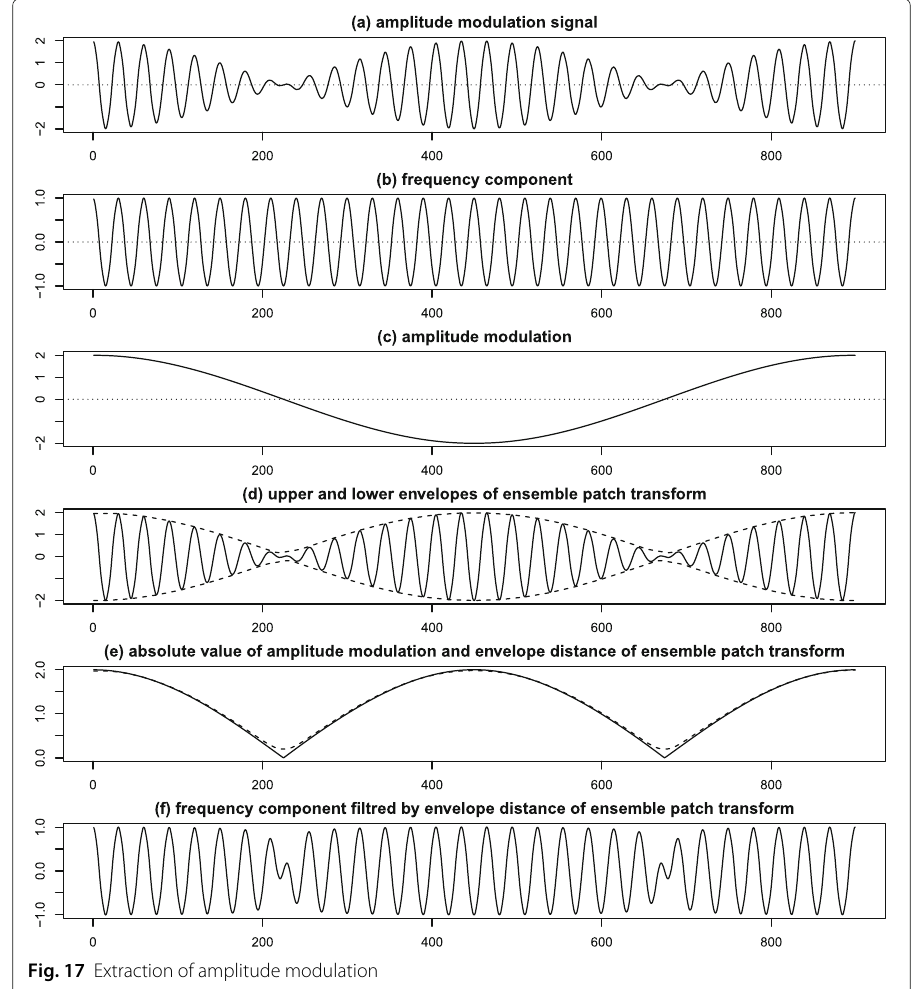
Fig. 17 Extraction of amplitude